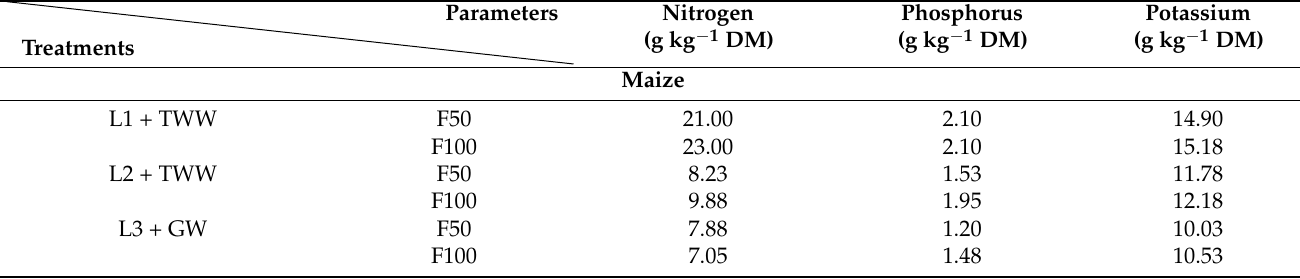
Table 8. Interaction effects of water resources and fertilization treatments on macro-elements content of maize, sorghum, and pearl